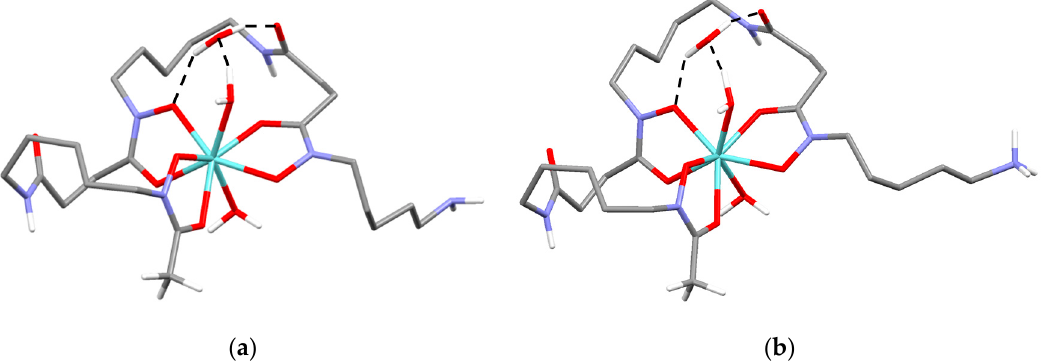
Figure 5. Calculated lowest energy conformers of: [ZrDFO] + ( a ), [ZrHDFO] 2+ ( b ).